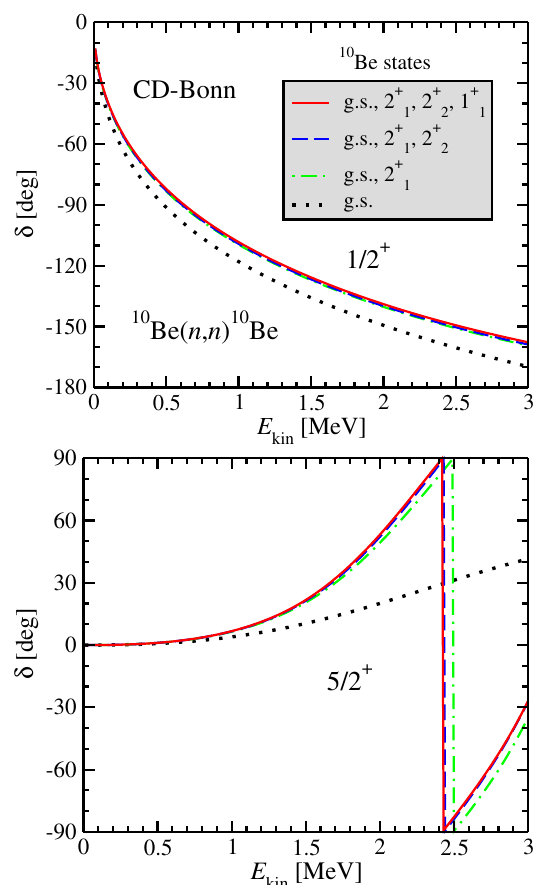
(cid:41)(cid:76)(cid:74)(cid:17) (cid:20)(cid:22)(cid:17) Calculated n - 10 Be phase shifts as a function of the rel- ative kinetic energy in the c.m. frame E kin , using the CD-Bonn NN potential [30] at (cid:2) Ω = 13 MeV: (top panel) 2 S 1 / 2 and (bot- tom panel) 2 D 5 / 2 results. The NCSM / RGM results were obtained using n + 10 Be configurations with N max = 6 g.s., 2 + states of 10 Be. The obtained 2 S 1 / 2 scattering length is + 10 . 7